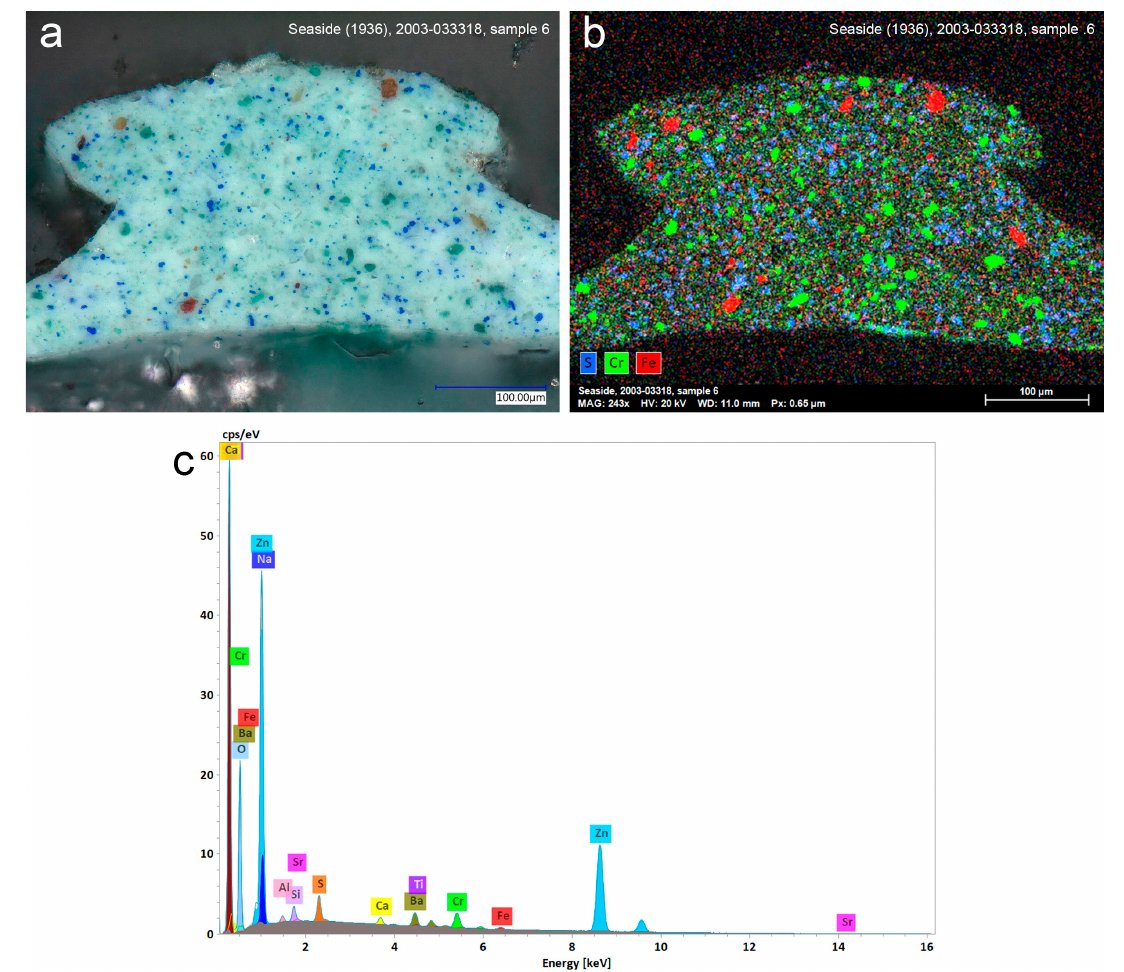
Figure 8. Microscopy image ( a ), corresponding SEM-EDS elemental map ( b ) and SEM-EDS spectra ( c ) of sample 6, extracted from Seaside , 1936. The SEM-EDS analyses show the distribution of S elements relating to ultramarine, Cr relating to viridian and Fe attributing to yellow iron-containing earth in the paint sample.